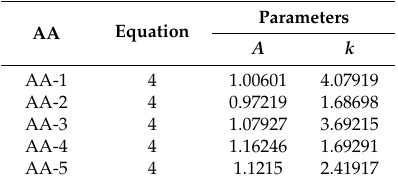
Table 1. Correlation equations and regressed parameters A and k for emulsions with different AAs.